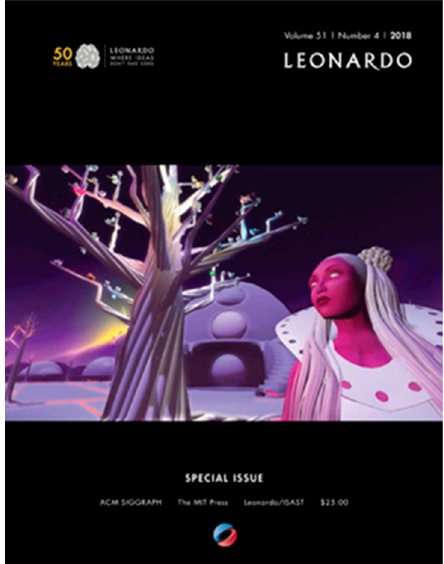
Figure 9. Leonardo Journal SIGGRAPH 2018 Special Issue, cover image “She Falls for Ages” (2017) by Skawennati. Used by permission of Skawennati and MIT Press.